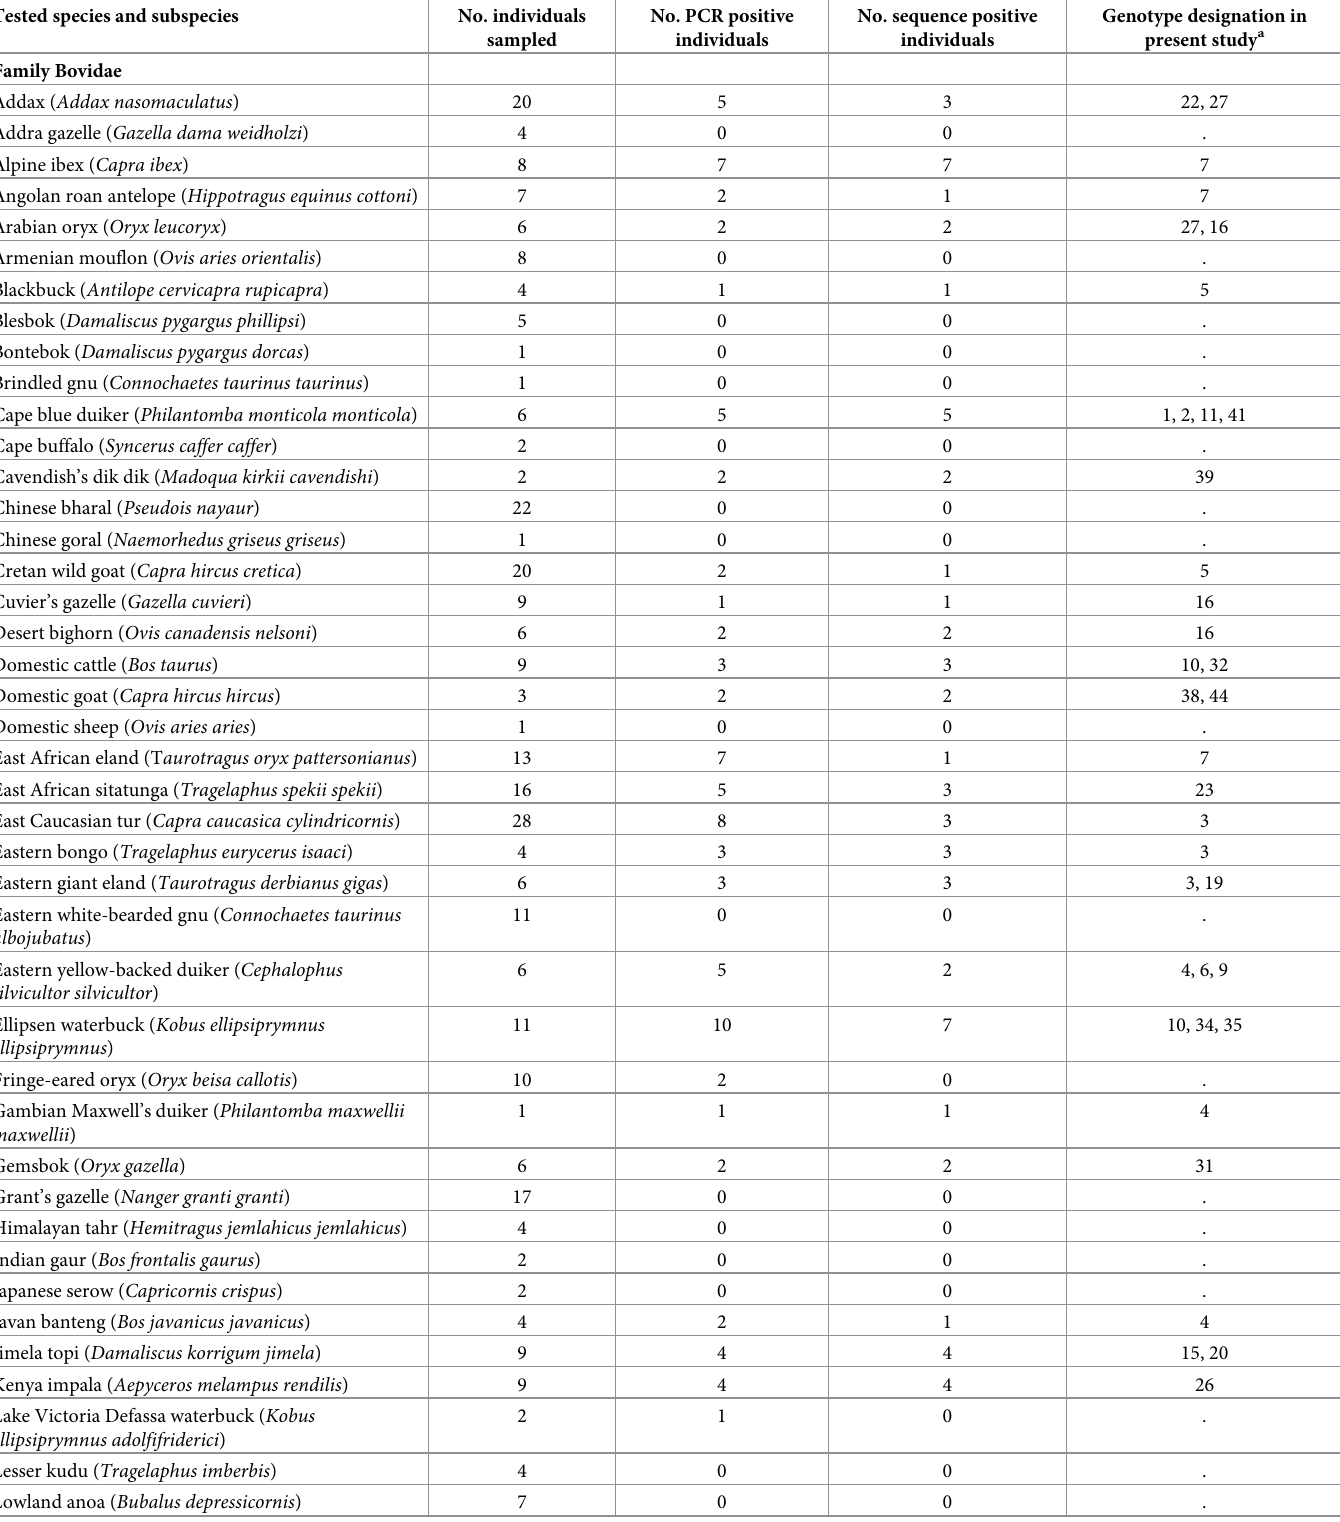
Table 1. Summary of the sample population, PCR results, and viral genotypes identified by species. Tested species and